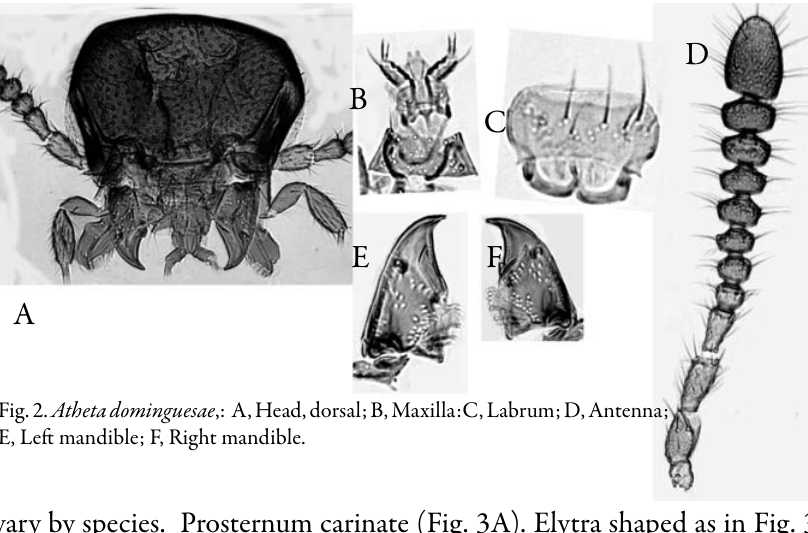
Fig. 2. Atheta dominguesae ,: A, Head, dorsal; b, Maxilla:c, Labrum; D, Antenna; e, Left mandible; F, right